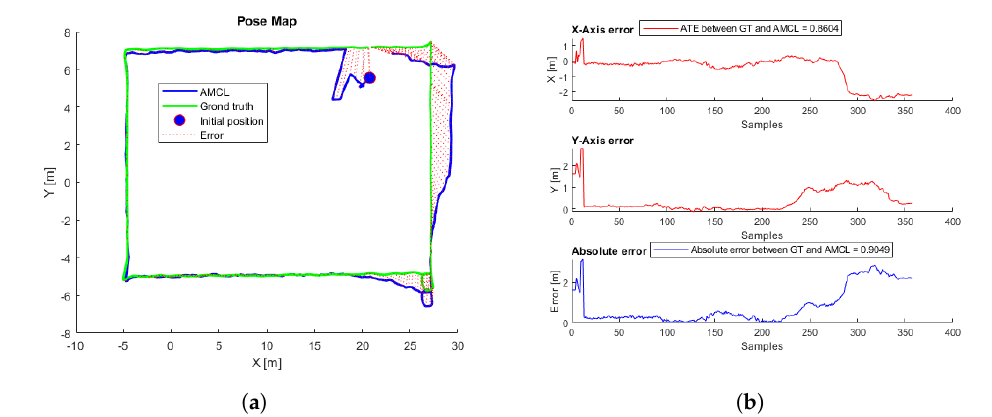
Figure 14. ( a ) AMCL simulation test with the lowest ATE. AMCL (blue), ground truth (green), take-off position (blue circle), error (red). ( b ) AMCL errors.